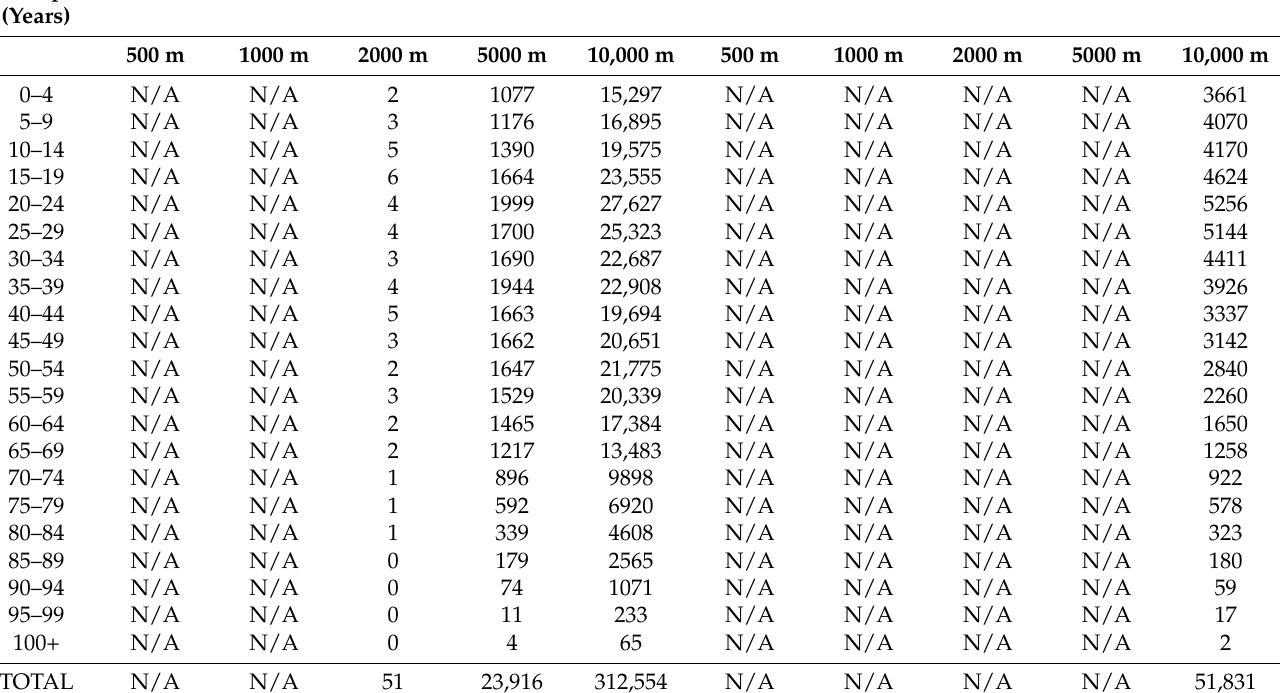
Table 6. Populations living in the vicinity of two plants in 2018 (Etex and Toptec—Manizales; Incolbest—Bogot á and Eternit—Sibat é